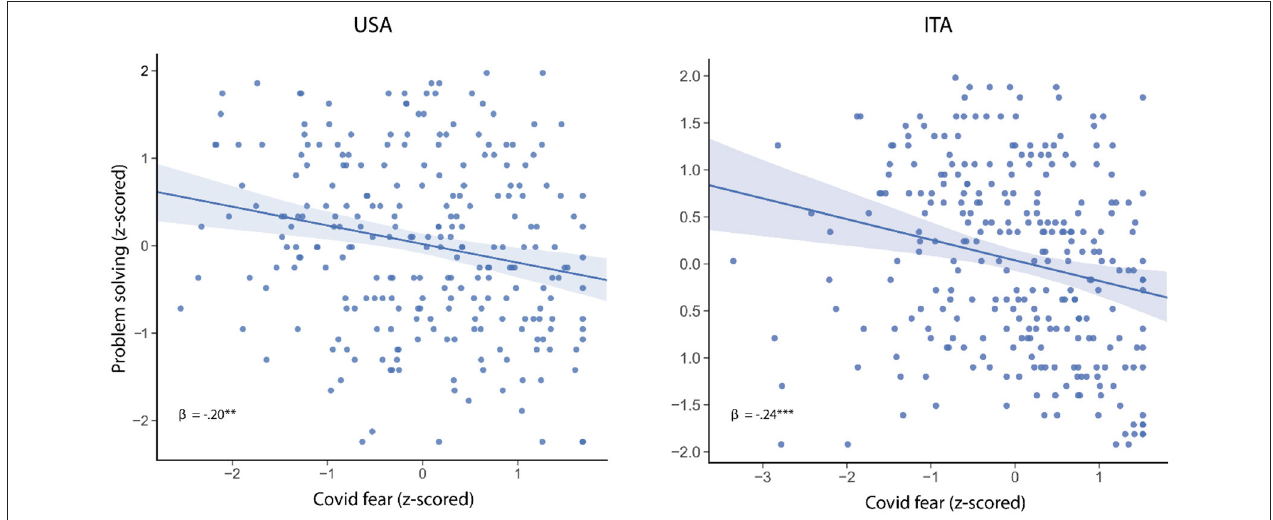
FIGURE 3 | Fear of getting COVID-19 negatively predicts problem-solving in the USA and ITA samples. Bands indicate 95% CI. **significance at p < 0.01; ***significance at p <